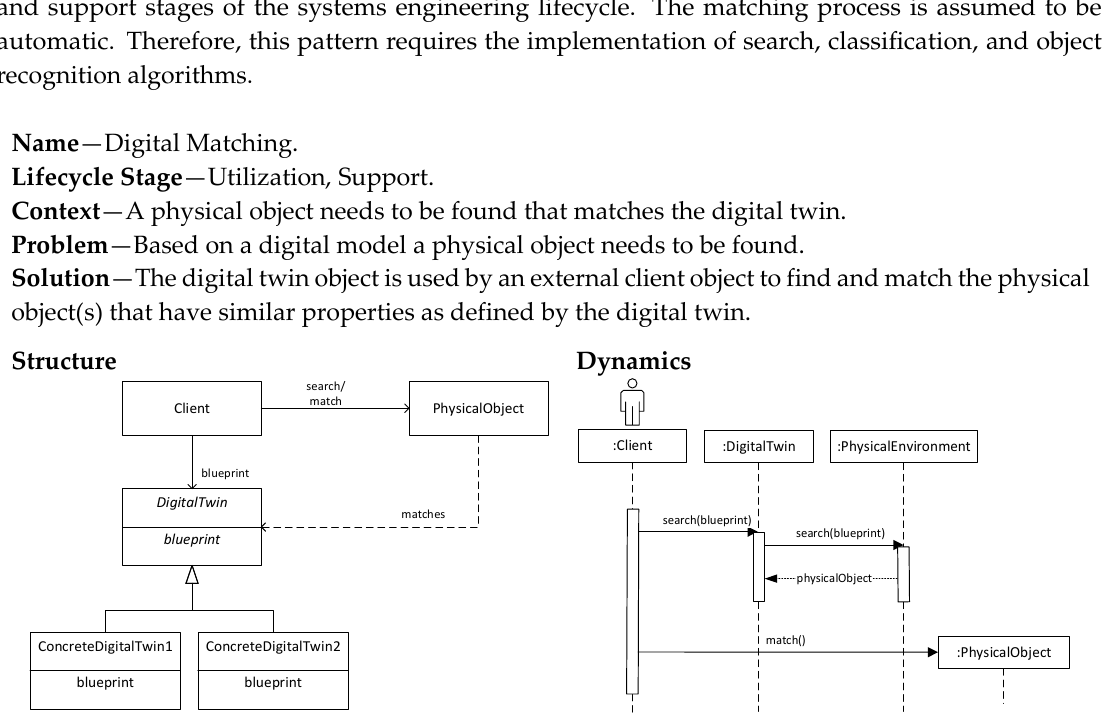
Figure 9. Digital Shadow pattern.